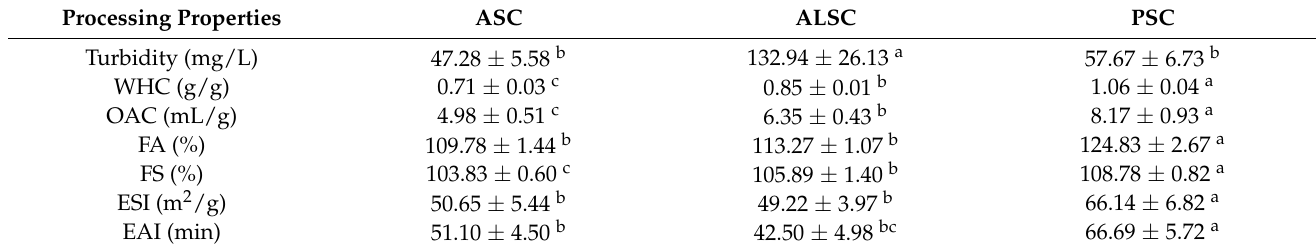
Table 4. Effects of extraction methods on the functional properties of chicken bone